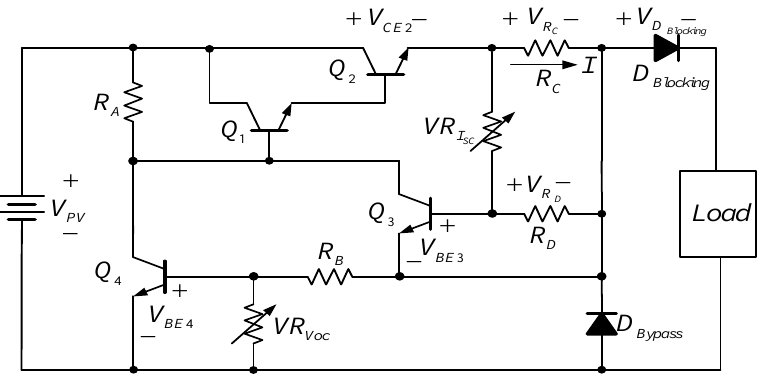
Figure 1. PV module simulator circuit.